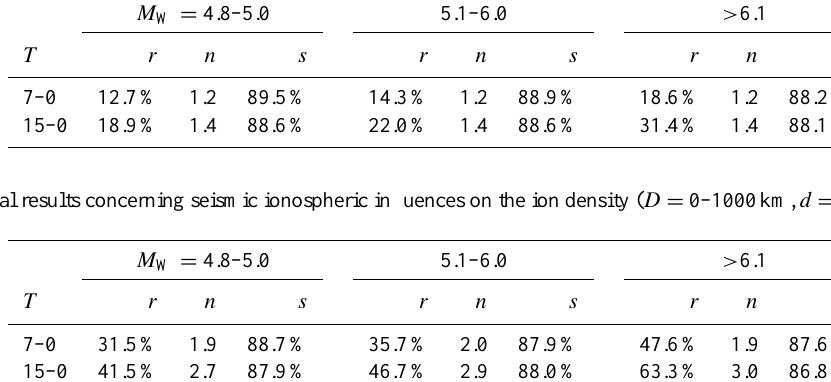
Table 3. The statistical results concerning seismic ionospheric influences on the ion density ( D = 0–500km, d = 0–1000km). M W = 4.8–5.0